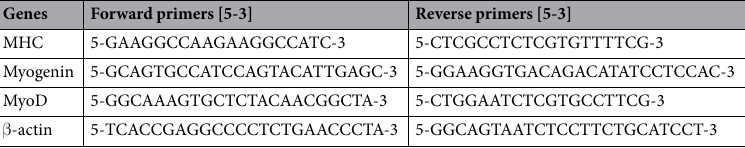
Table 1. Primer sequences used for myogenesis related mRNA expression in L6 skeletal muscle cell